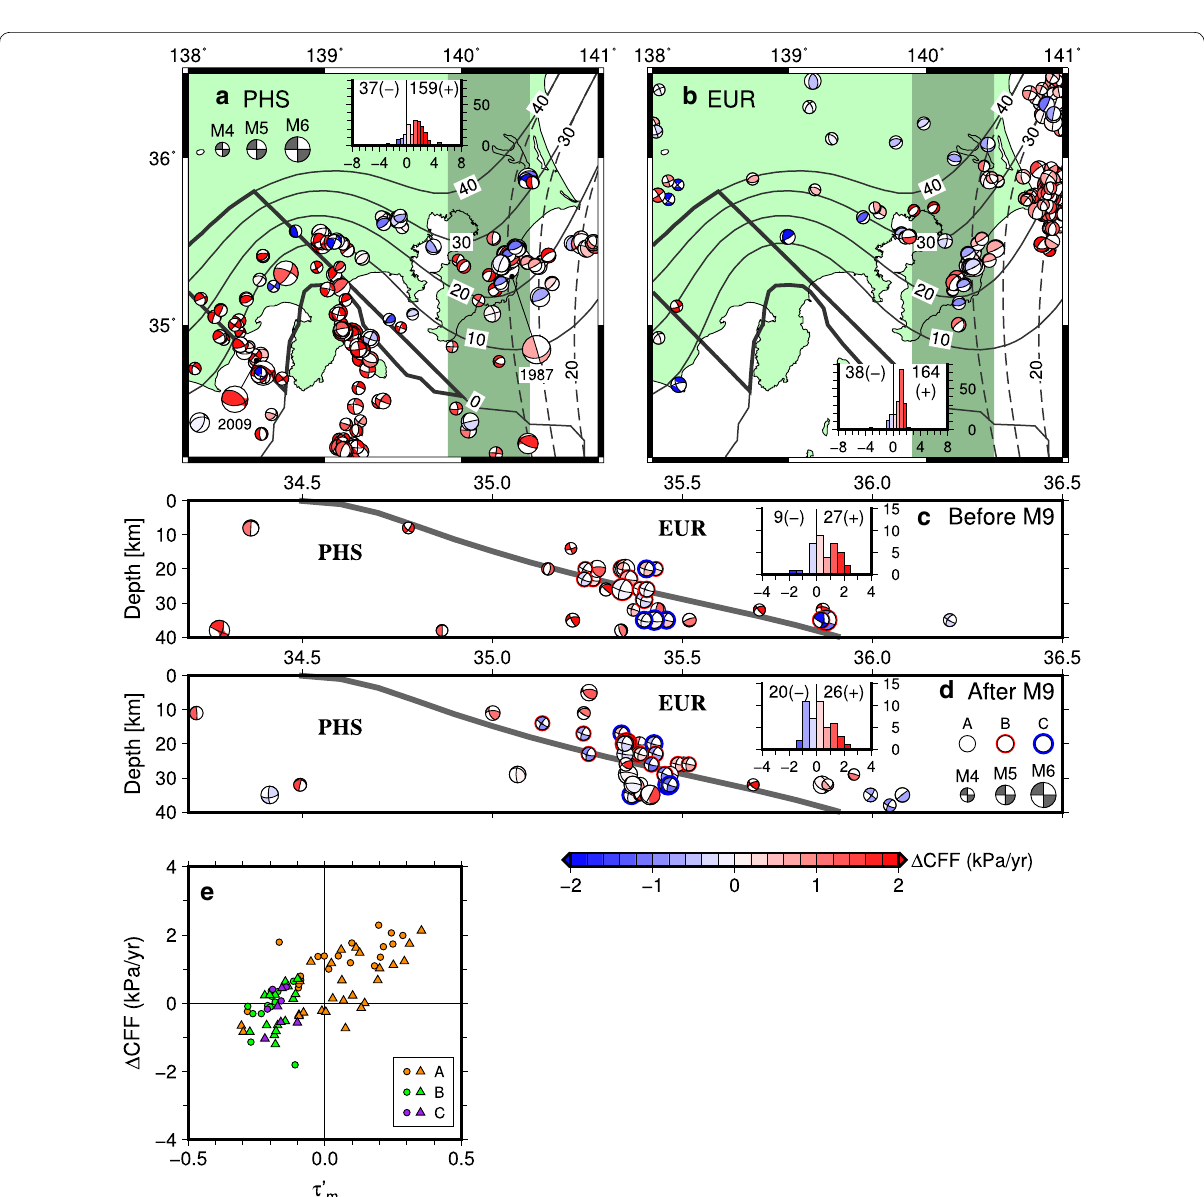
Fig. 4 a – d Same as Fig. 2a–d, but focal mechanisms, colors, and frequency histograms with respect to ΔCFF. Distribution of earthquakes with positive ( ) and negative ( ) ΔCFF shown in histograms. a , b Locked zone (same as Fig. 3) outlined with bold black line. e Fault type ( τ ′ m ) vs. ΔCFF + − plotted in vertical section, range same as for c and d . Circles indicate events before the 2011 M9 Tohoku earthquake and triangles indicate events after. Symbol color (orange, green, and purple) denotes Group A, B, or